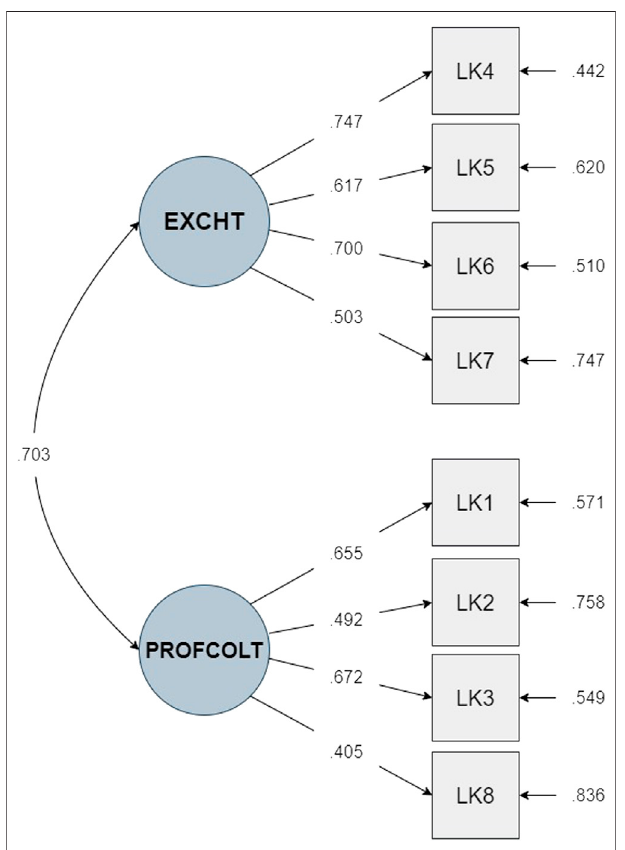
FIGURE 1 | Initial measurement model of two forms of collaboration. Note: All displayed values signi fi cant at p ≤ 0.05.